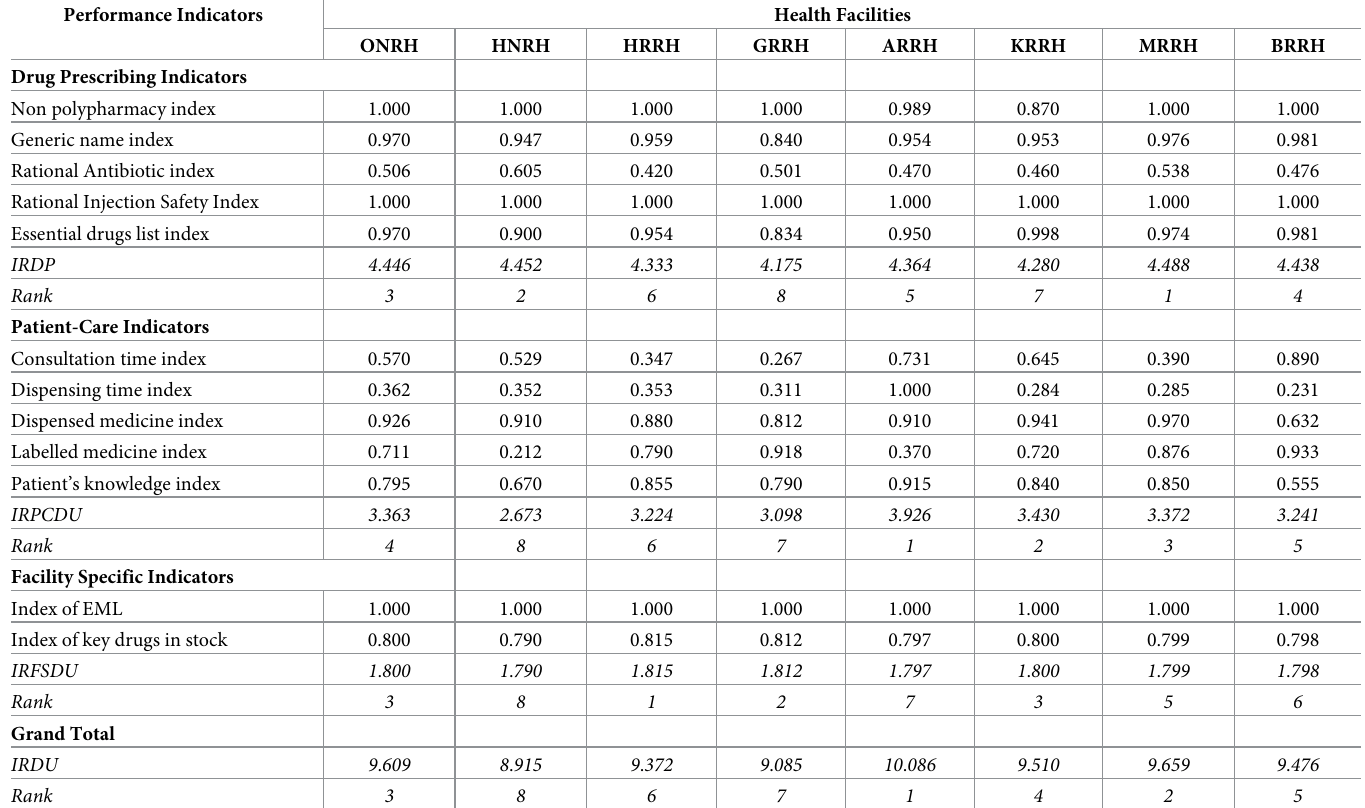
Table 7. Index of rational medicine use in Eritrean zonal and national referral